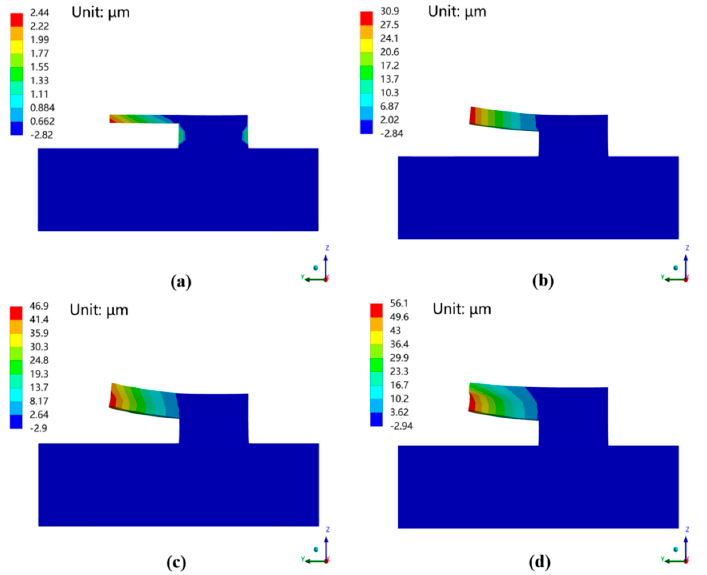
Figure 10. Deformation at different study points: ( a ) Layer 1; ( b ) Layer 2; ( c ) Layer 3; and ( d ) Layer 4.